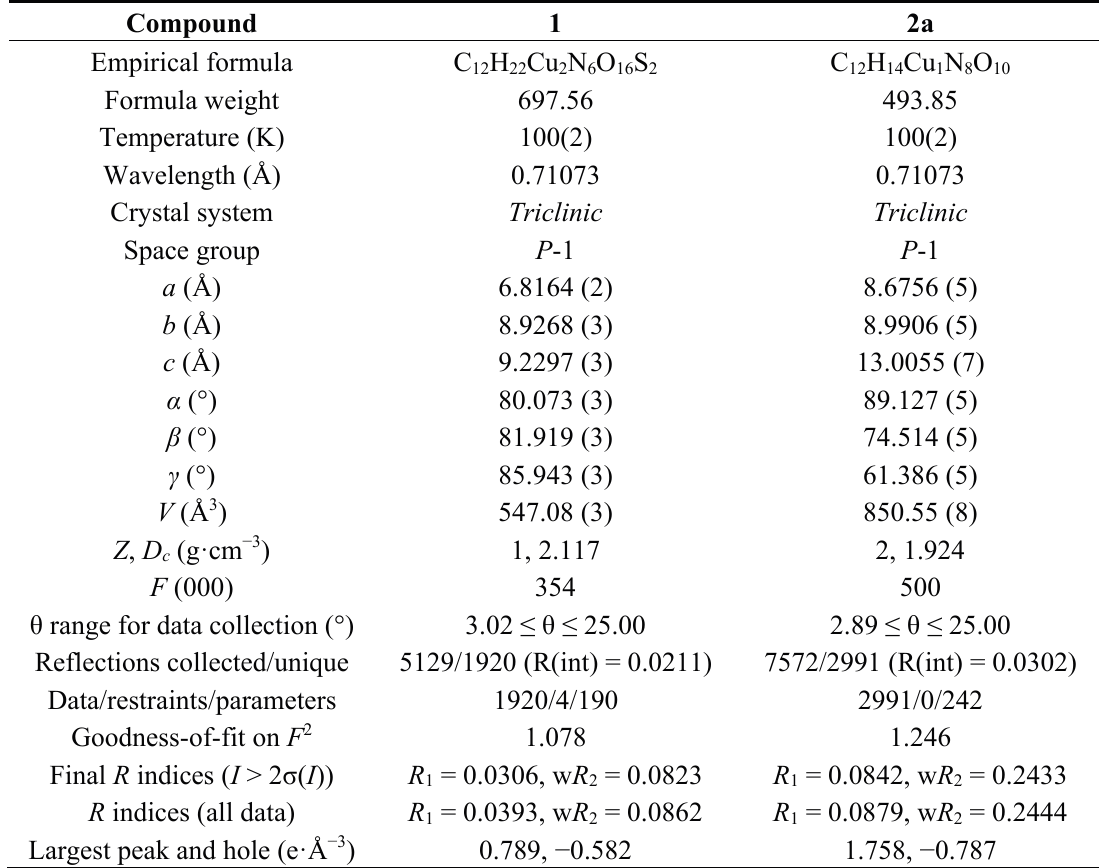
Table 1. Crystal data and structure refinements for 1 and 2a